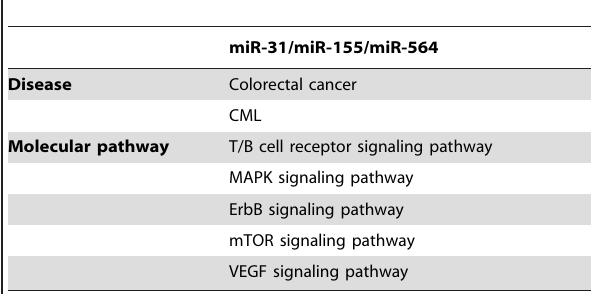
Table 4. Ingenuity analysis of miRNA predictive